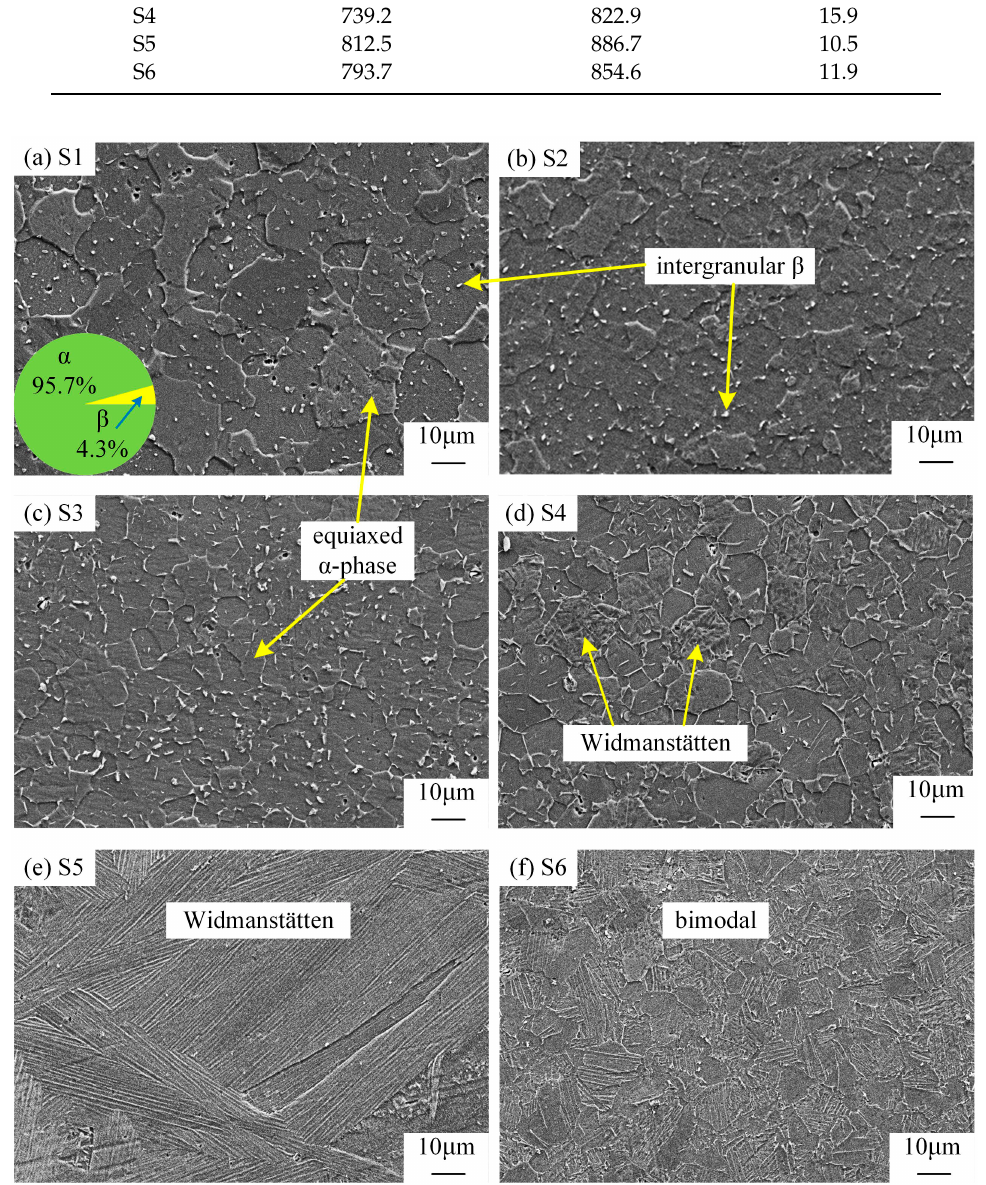
Figure 3. The microstructures of TA17 after different annealing processes. ( a ) S1; ( b ) S2; ( c ) S3; ( d ) S4; ( e ) S5; and ( f ) S6.